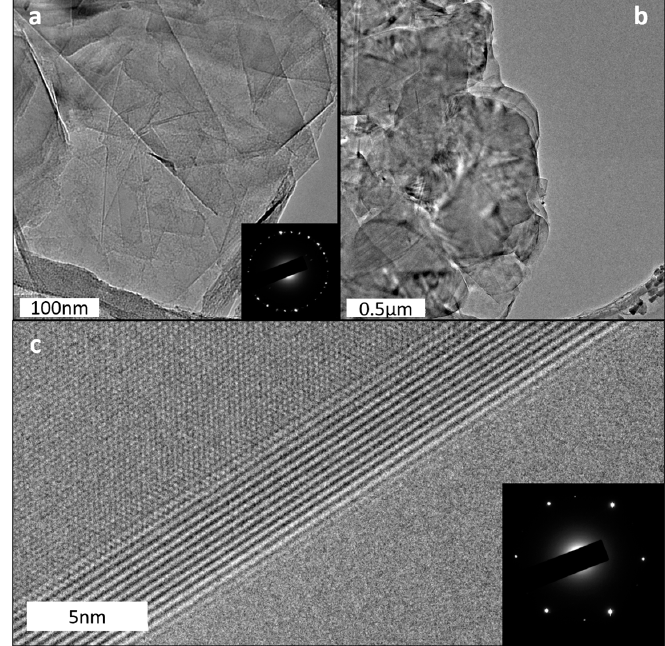
Figure 14. TEM images of the sample LiBN05: ( a ) Crystallized sheets stacked on each other; ( b ) Diffraction contrast between sheets evidencing the sample crystallization; ( c ) HRTEM image on a thin zone of a sheet (inset: corresponding SAED).